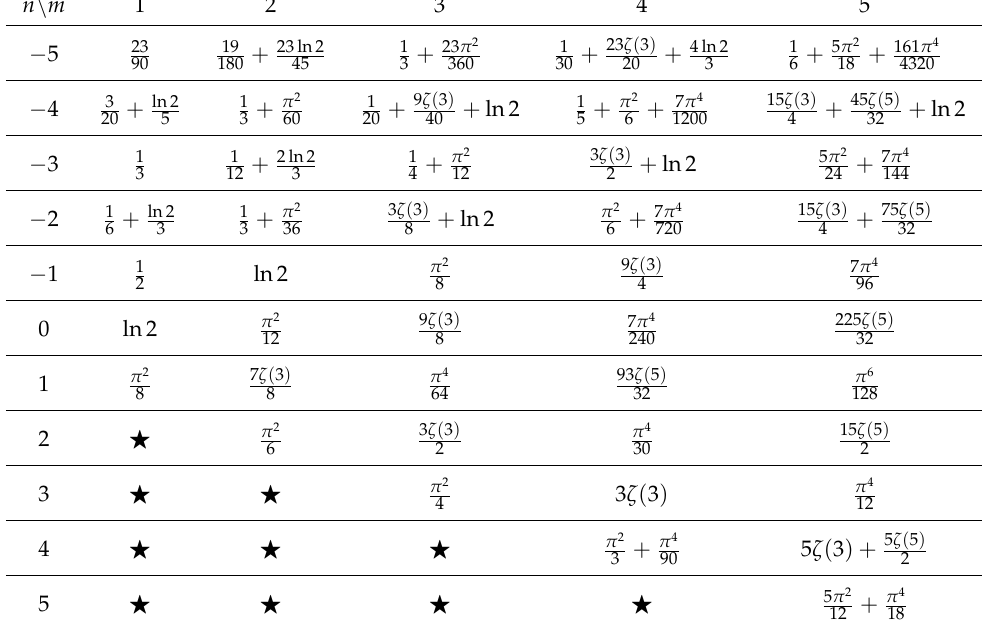
Table 1. Values for H ( m , n )